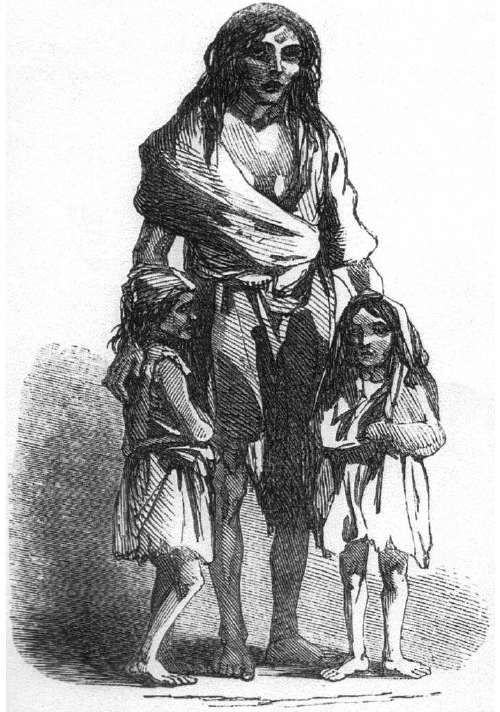
Figure 3: James Mahoney, Bridget O’Donnell and her two children , in The Illustrated London News, 22 December 1849 (p.